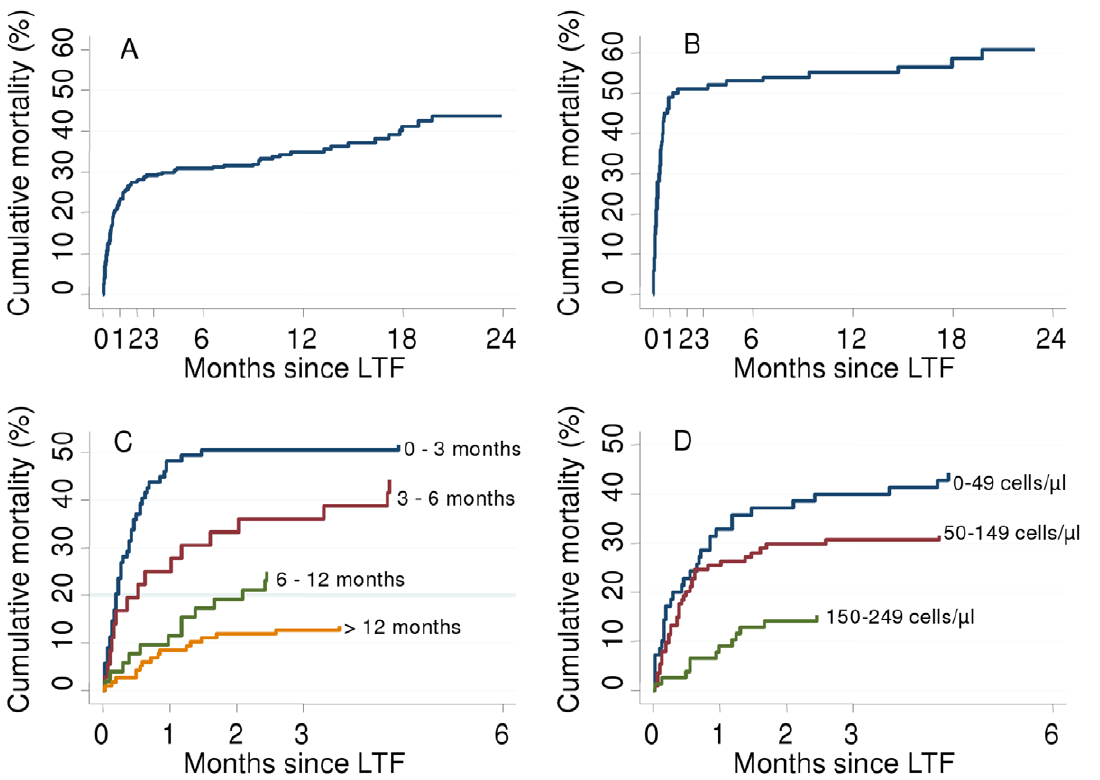
Figure 5. Cumulative mortality after LTF. These Kaplan-Meier graphs show cumulative mortality over time after the last recorded visit for patients originally classified as LTF in whom vital status could be ascertained through the national vital registration system: A - among all LTF; B - among LTF on ART for less than 3 months; C stratified by duration on ART at time of LTF; D stratified by CD4 cell count at initiation on ART. Patients recently started on ART and with lower CD4 counts had higher mortality after LTF. LTF, loss to follow-up.